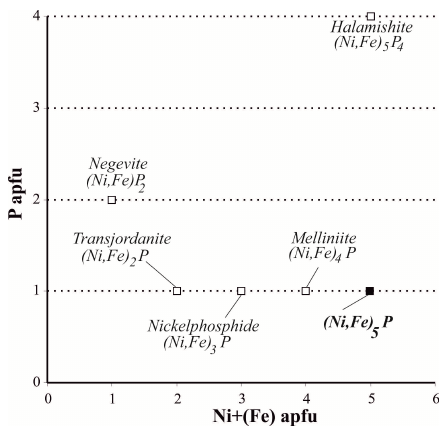
Figure 11. Binary diagram of P versus Ni + (Fe), apfu (atoms per formula unit), showing the composition of the Ni-phosphide found in the Bakanov Kluch chromitite (black square), compared with those of the minerals with Ni > Fe described in the system Ni–Fe–P (open squares). Literature data from [25–28].